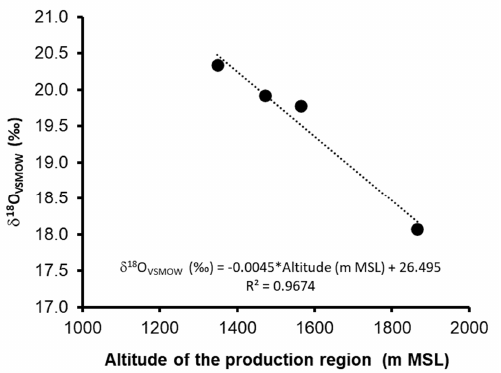
Figure 4. Relationship between the altitude of the production region of silver class 100% agave tequila and the δ 18 O VSMOW. 3. Materials and Methods 3.1. Samples